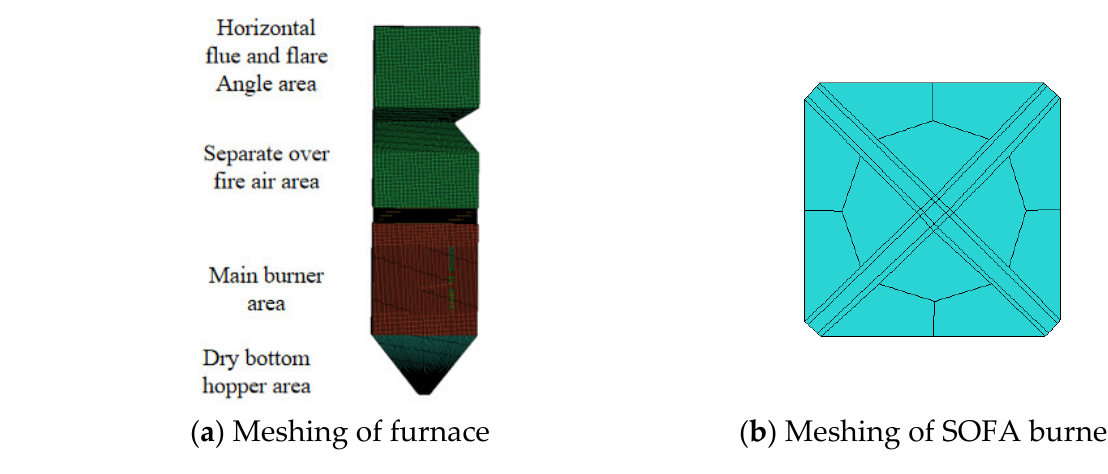
Figure 3. Mesh generation of the furnace ( a ) and SOFA burner ( b ). Table 3. The temperature difference varies with the grid numbers.